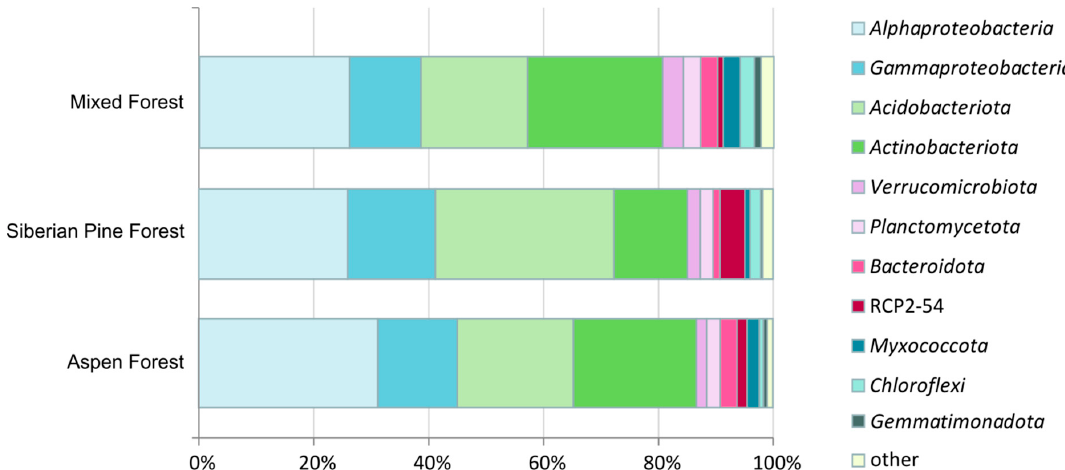
Figure 5. Bacteria community composition in soils of the three forest sites according to the results of Illumina-based sequencing of 16S rRNA genes. The composition is displayed at the phylum level with the only exception of the Proteobacteria , which are displayed at the level of classes. The relative abundance values represent averages of four replicate data sets.